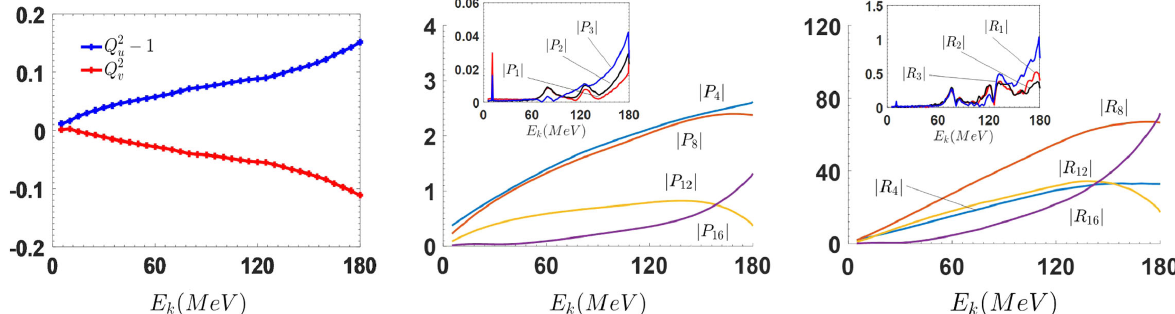
− 1 and Q 2 11. Values of (left) Q 2 , (middle) the Fourier coefficients of g ð θ Þ , and (right) the Fourier coefficients of J ð θ Þ for u v different energy